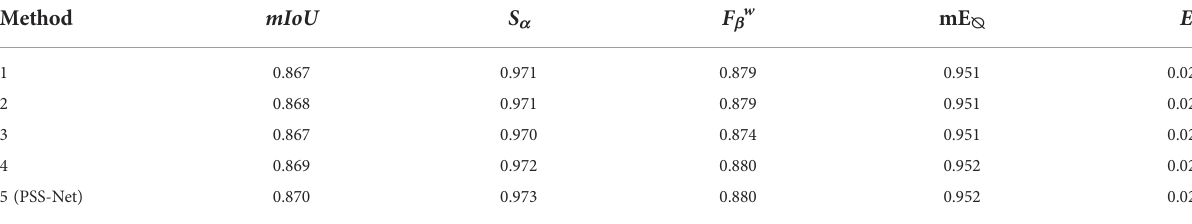
TABLE 3 Comparative accuracies of testing with feature maps fusion using addition and average, multiplication, addition, and attention (proposed method) on MAS3K dataset (case 1).